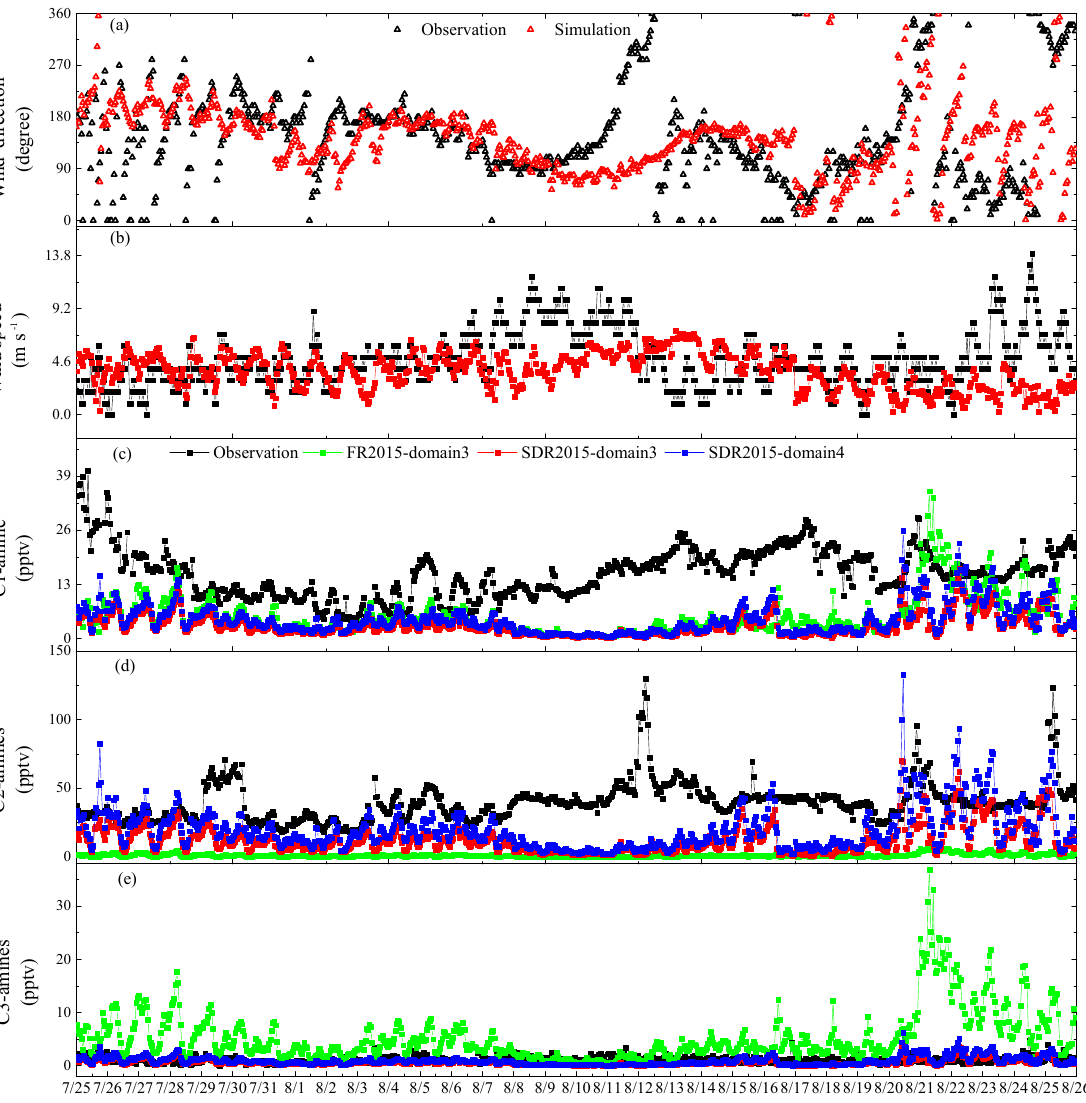
Figure 6. Comparisons of simulated and observed wind direction (a) , wind speed (b) , C1-amine (c) , C2-amines (d) , and C3-amines (e) concentrations at the Fudan site in Shanghai, China from 25 July to 25 August 2015. In ( c–e ), black, blue, red, and green lines present observations, simulated values in domain 4 based on SDR, domain 3 based on SDR, and domain 3 based on FR,